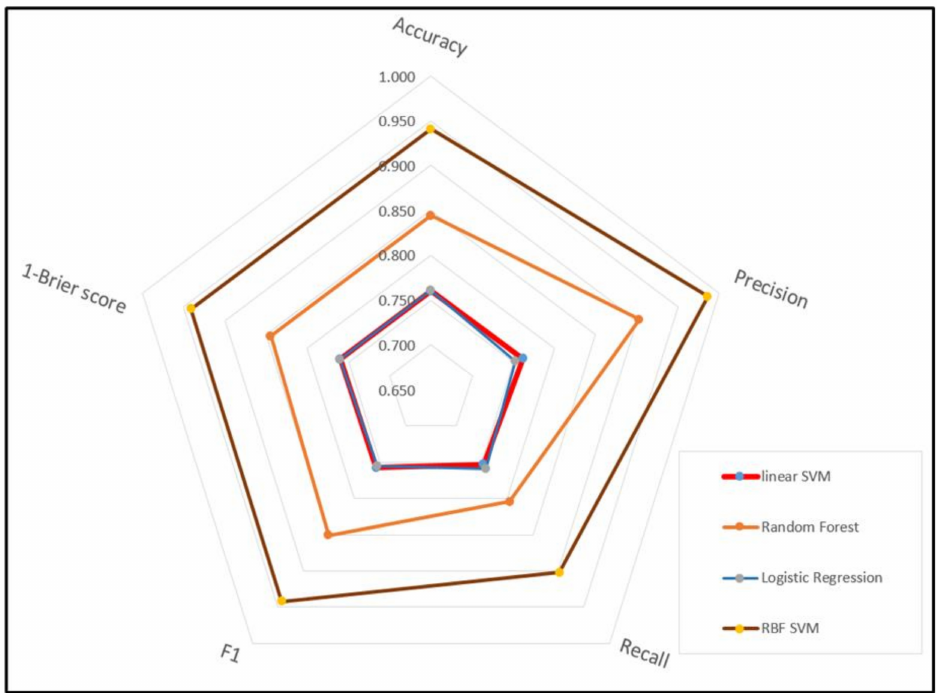
Figure 4. Performance measure among